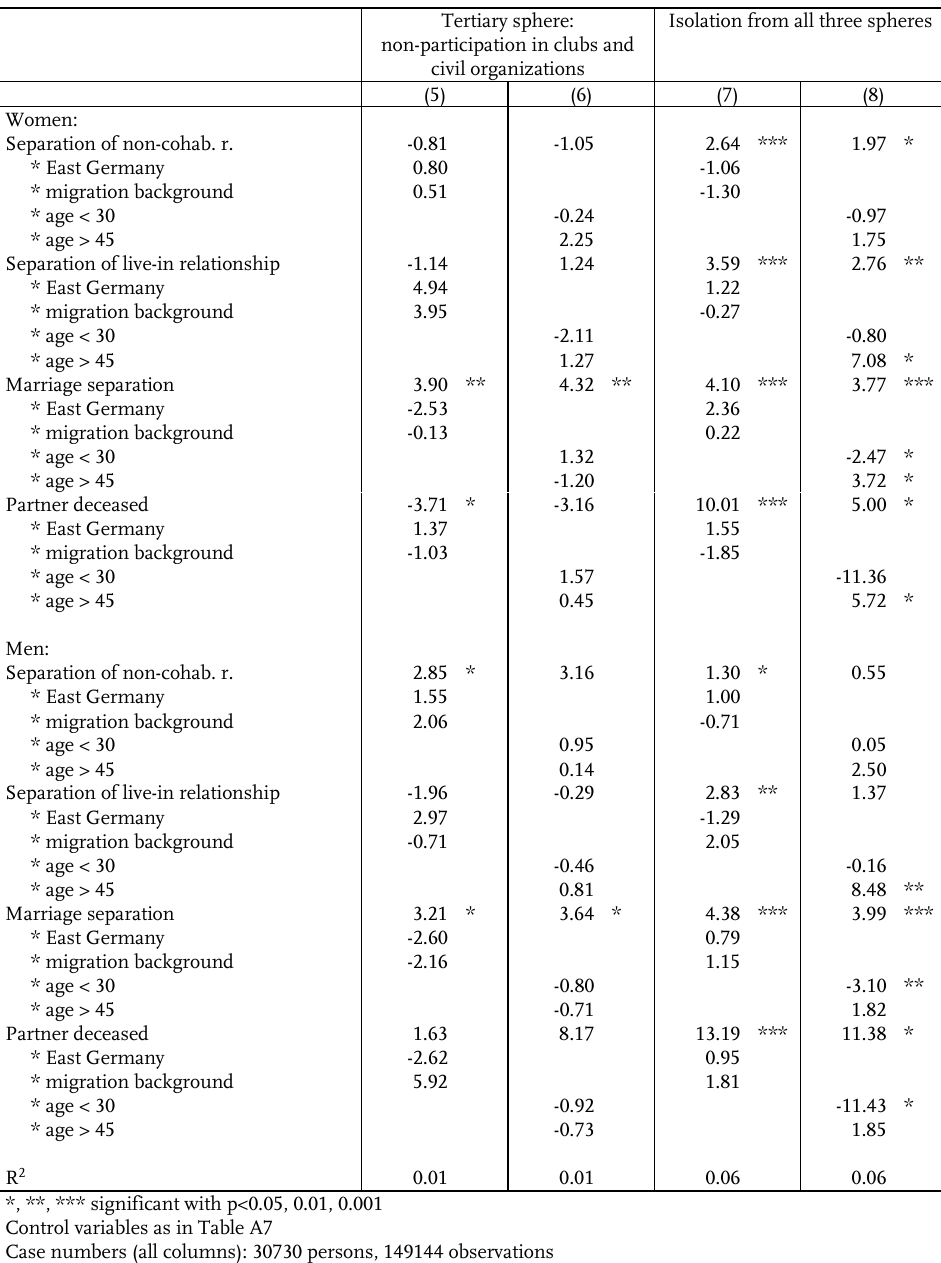
Table A.12 : Moderation of effects of relationship endings by region, migration background, and age (linear- probability models with fixed effects, percentage points) (continued) Tertiary sphere: Isolation from all three non-participation in clubs and civil organizations